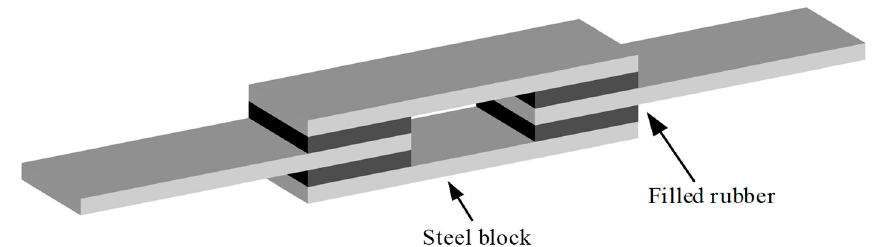
Figure 5. Illustration of the quadruple-lap shear specimen.